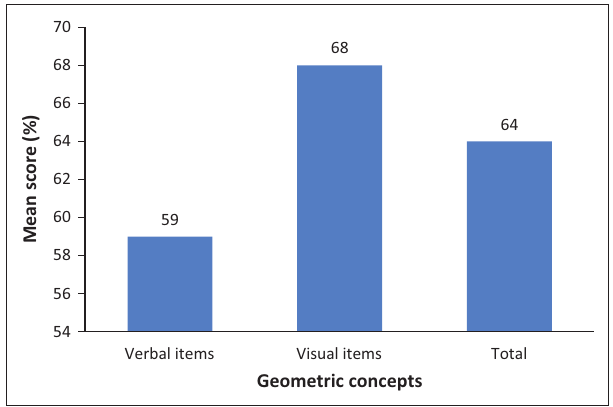
FIGURE 2: Performance of entry level mathematics education students in the geometry terminology TABLE 1: Performance of students in the multiple choice questionnaire in relation to pre-2014 matriculants and the matriculants of 2014. Year of passing matric n Mixed items (all) (mean score % )